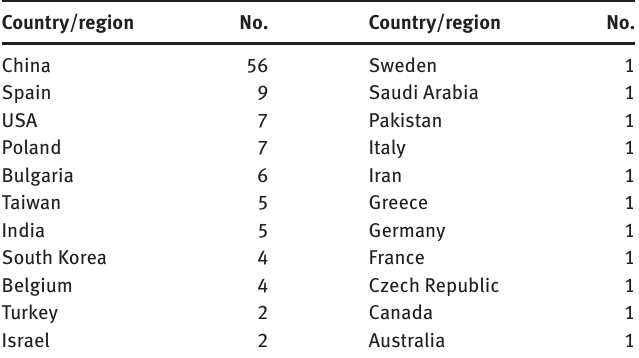
Table 3: Countries/Regions of Origin of the 100 Most Cited IFS Articles.